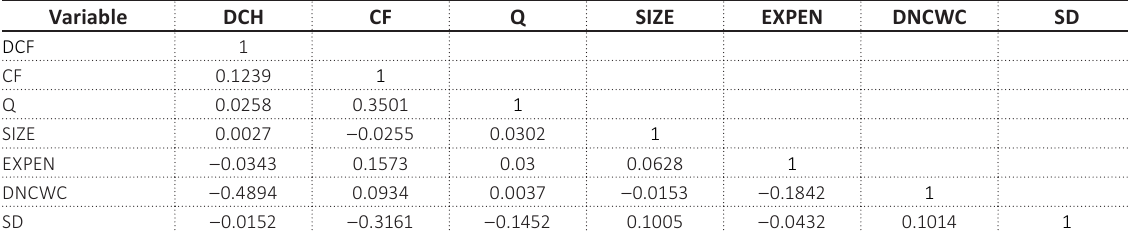
Table 3. Correlation matrix